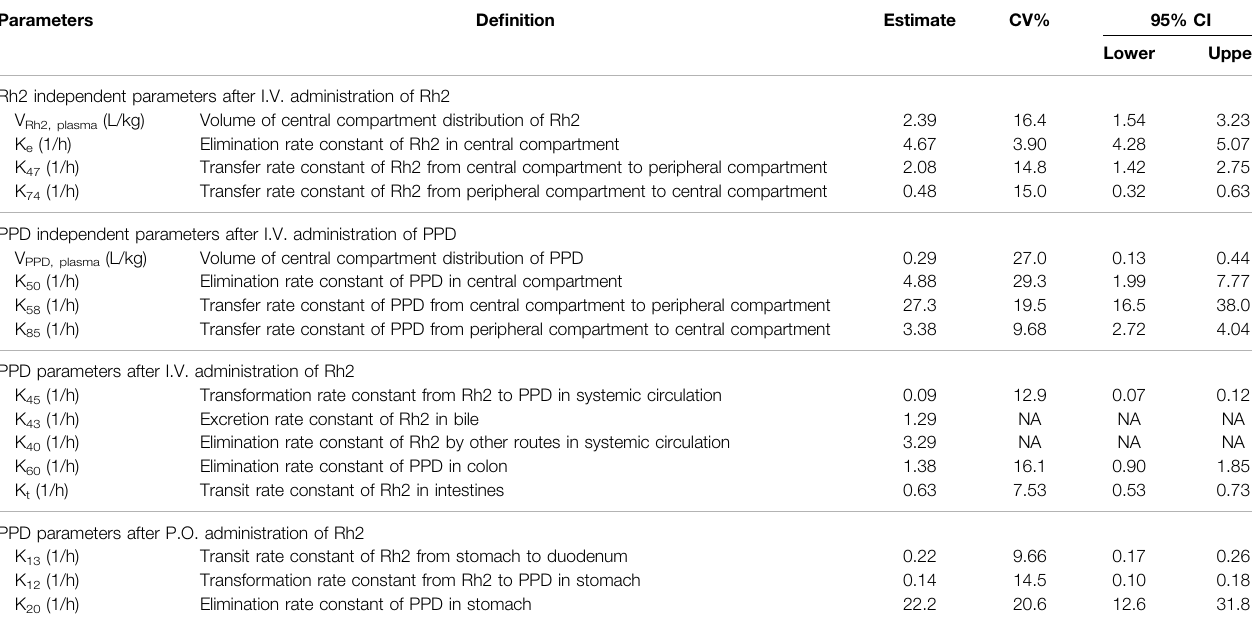
TABLE 2 | Summary of estimated pharmacokinetic parameters.